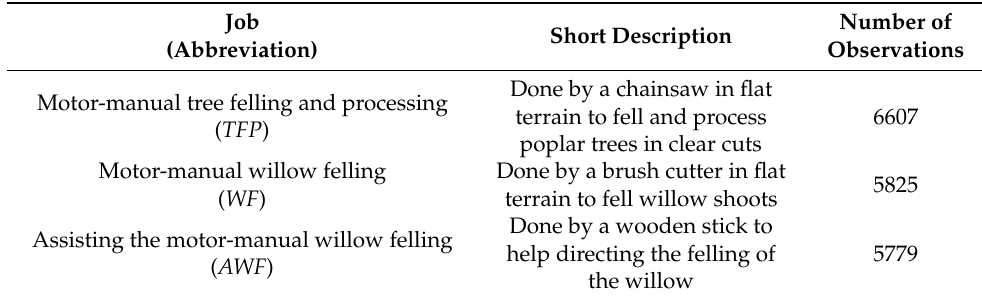
Table 1. Characteristics of the datasets used in the second case